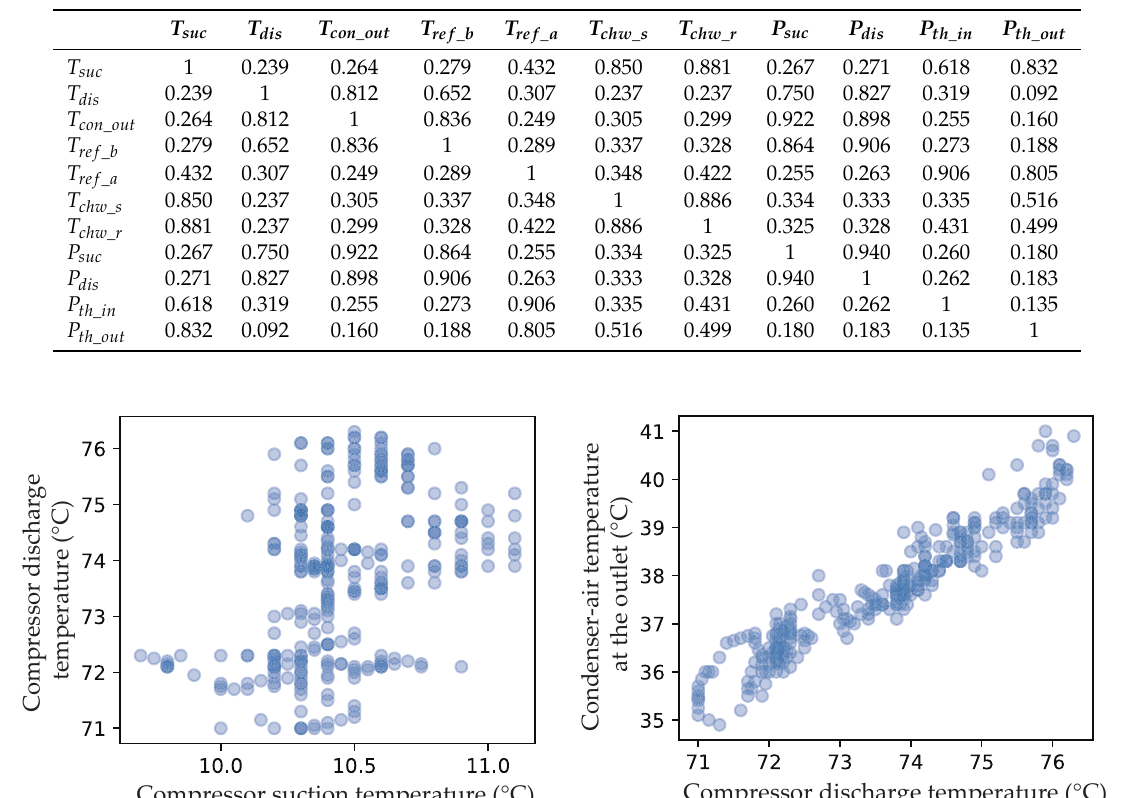
Table 2. MIC of different sensors.